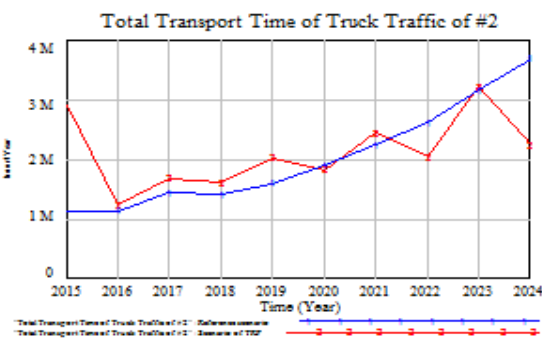
Figure 8. TRP effects on the total transport time of truck traffic on the regular highway